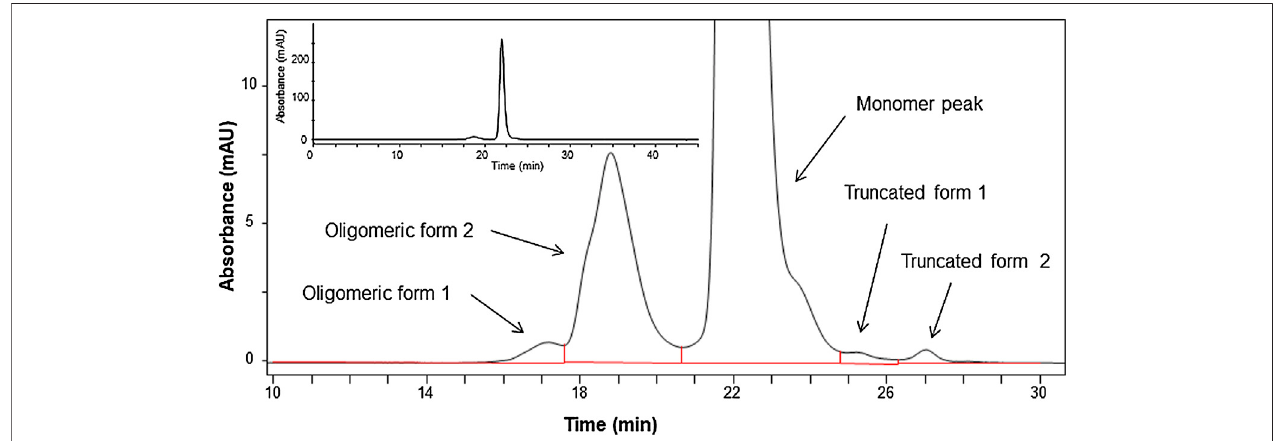
FIGURE 3 | Chromatogram analyzed by cation exchange chromatography (CEX) (A) and electropherogram analyzed by capillary isoelectric focusing (B) of the candidate reference material (RM).